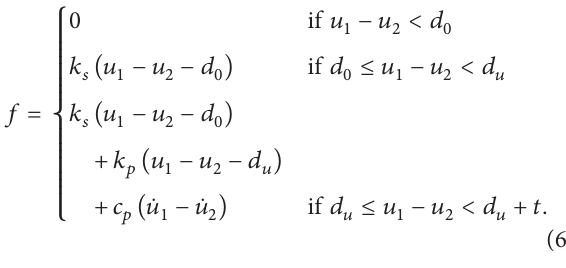
impact stiffness and damping coefficient of the Kelvin impact element, respectively. 𝑐 𝑝 can be calculated